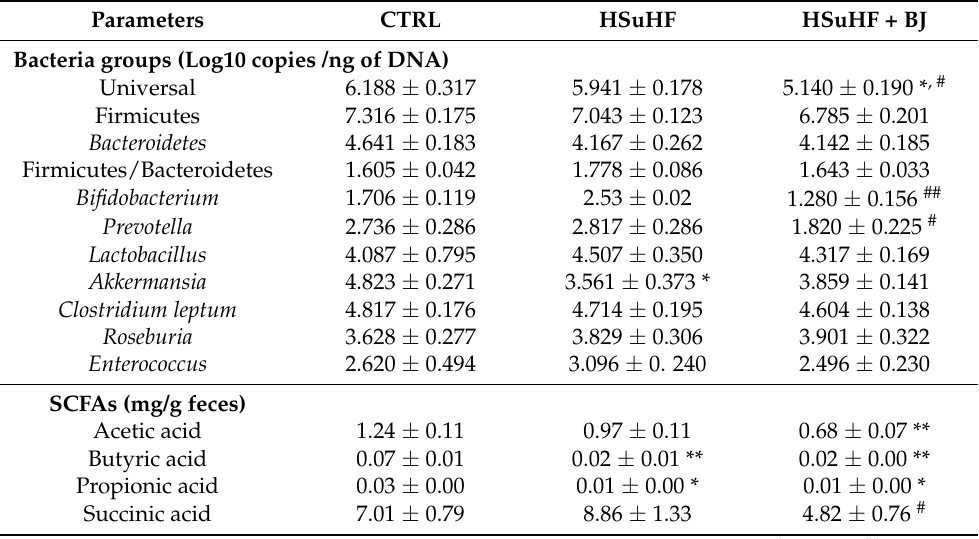
Table 3. Gut bacterial microbiota groups and SCFA contents in feces of CTRL, HSuHF, and HSu + BJ